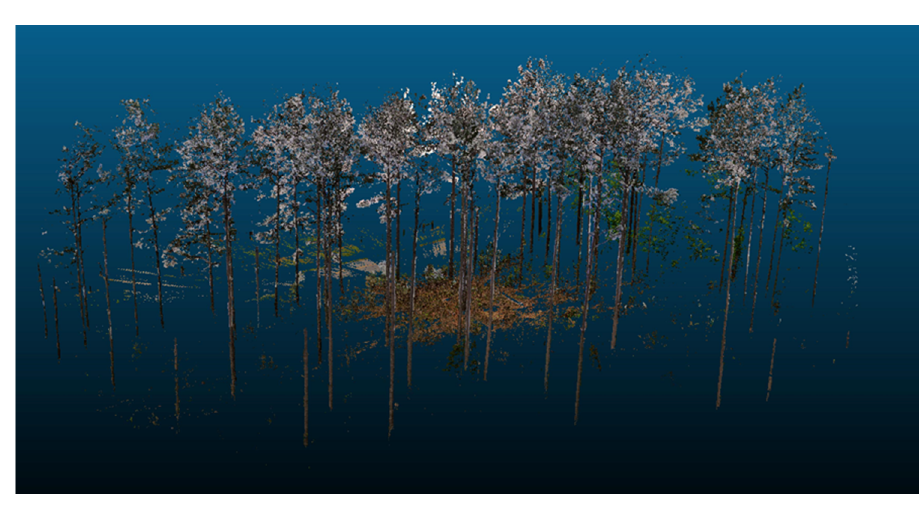
Figure 4. 3D Forest structure created by a terrestrial laser scanner (TLS).